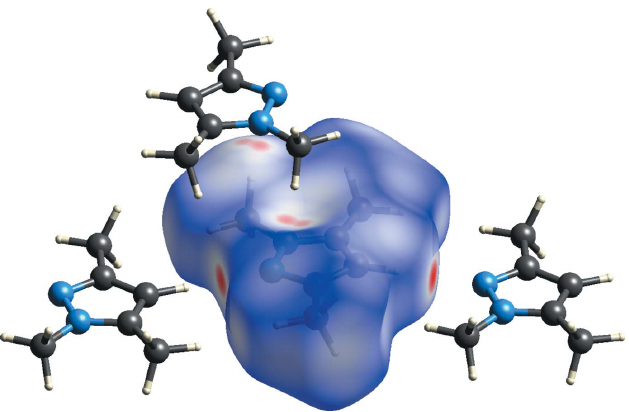
Figure 4 Hirshfeld surface (Turner et al. , 2017) about one 1,3,5-trimethyl-1 H - pyrazole moiety in 1 .